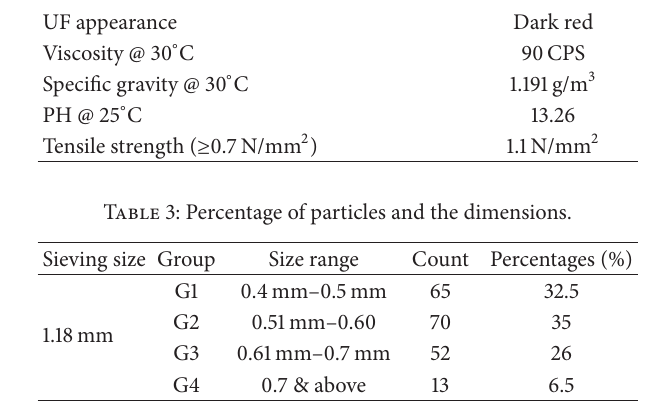
Table 1: Specification of UF. Table UF resin